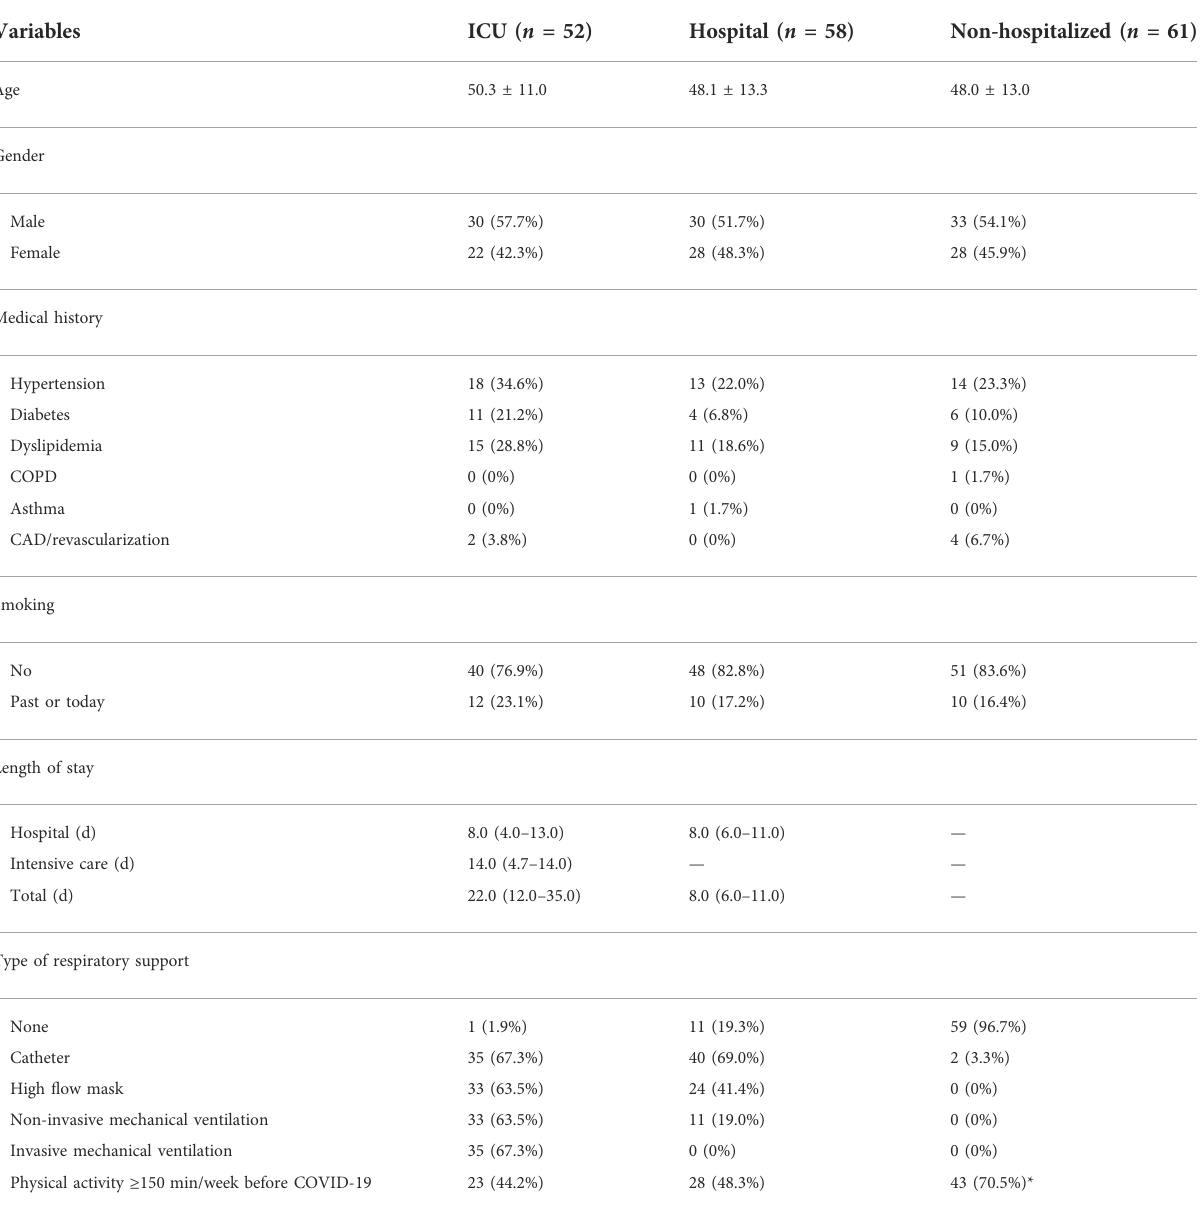
TABLE 1 General characteristics of participants of both sexes by the severity of